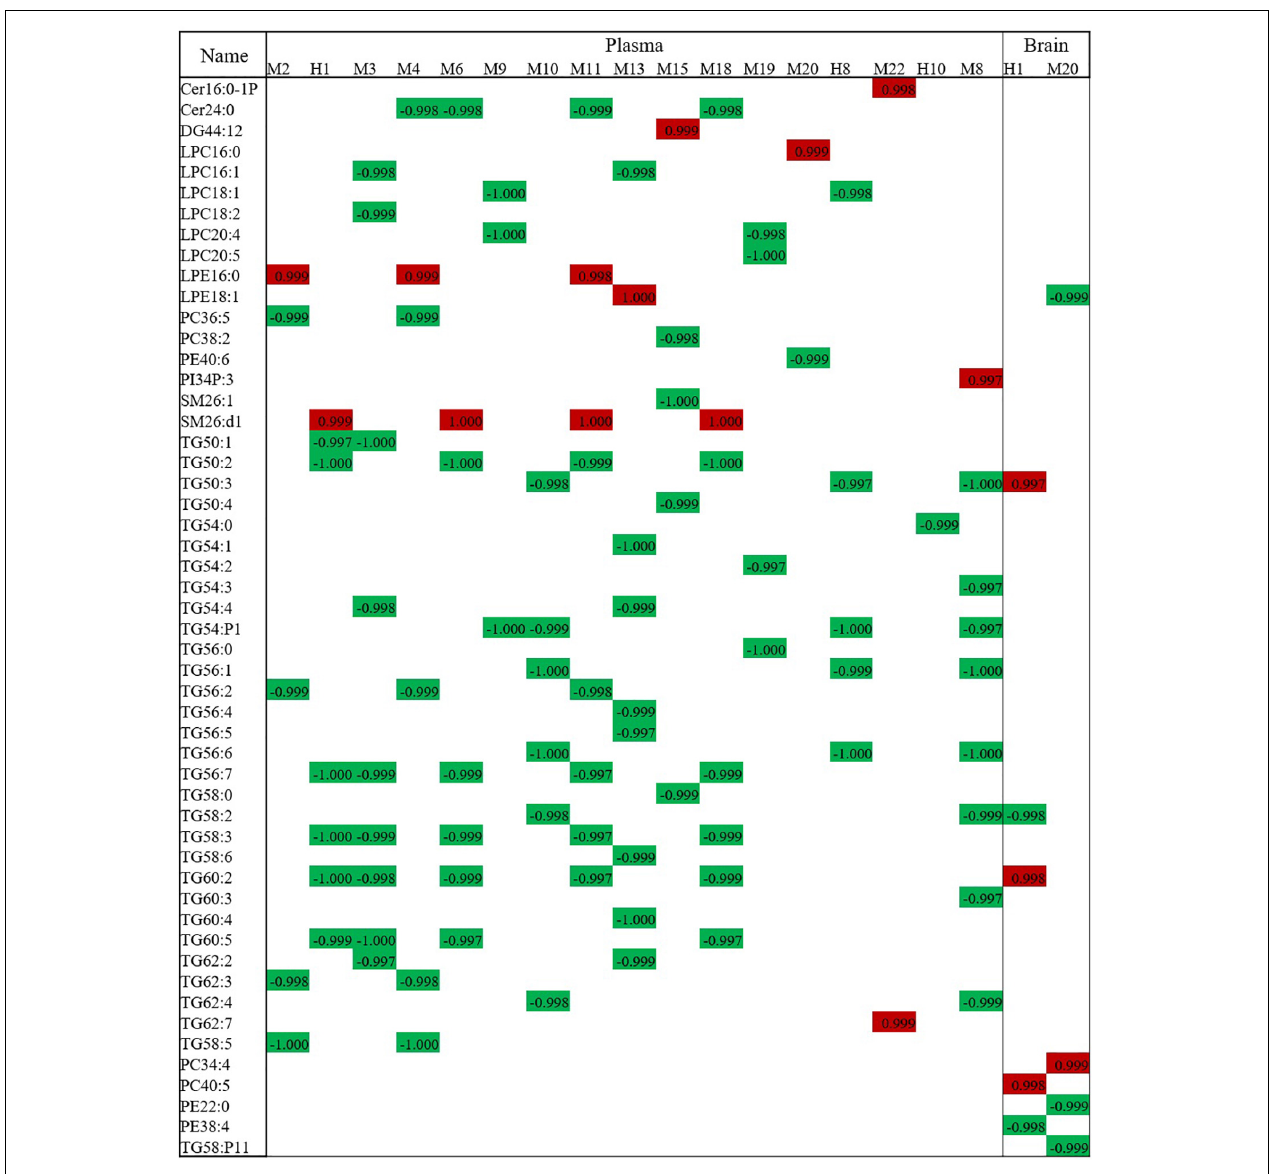
FIGURE 6 | Correlation analysis of lipid biomarkers with exogenous metabolites. The numbers stand for the correlation coefficient. Red means positive correlation and green means negative